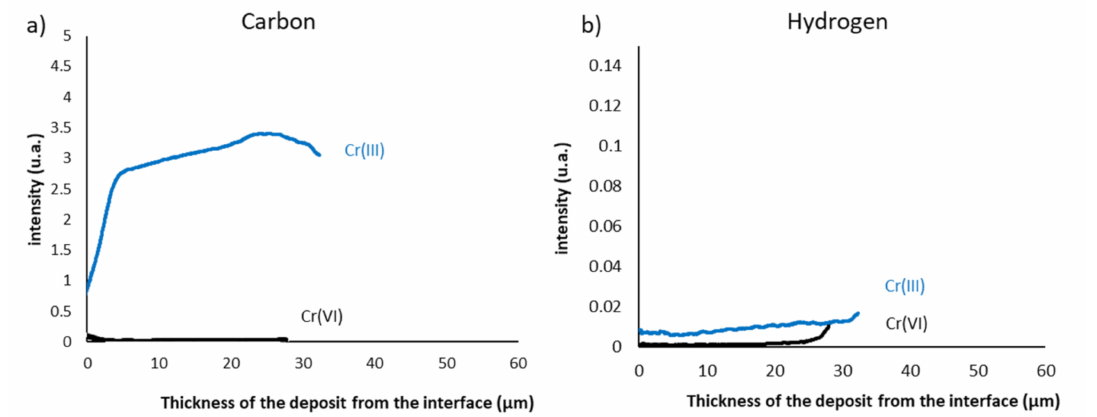
Figure 9. Evolution of the ( a ) carbon and ( b ) hydrogen content in trivalent and hexavalent chromium